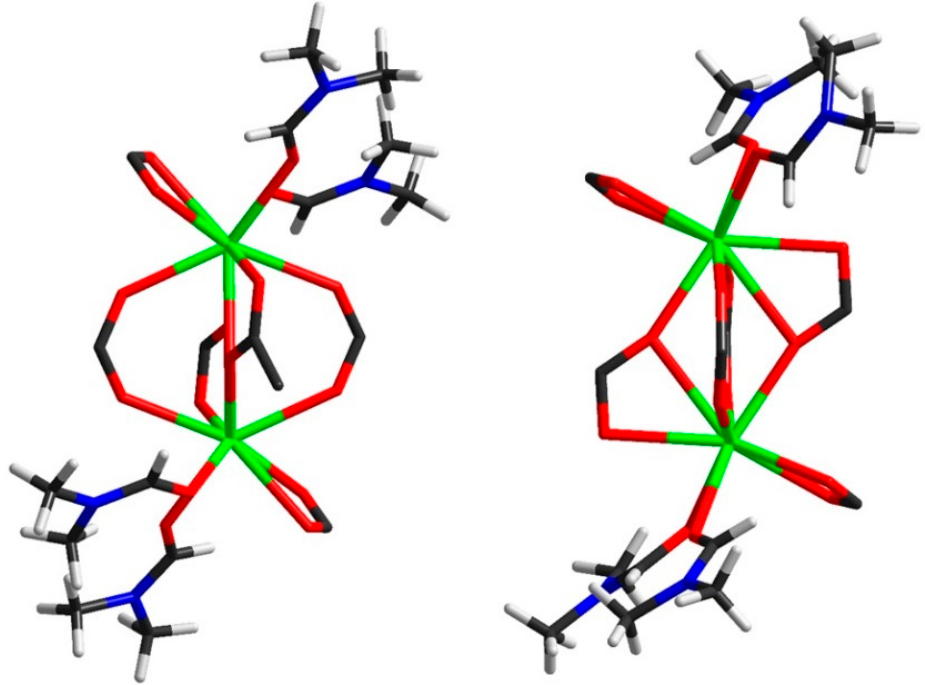
Figure 4. Geometry of the [La 2 (2,5-I-bdc) 6 (DMF) 4 ] units in 1 (left) and 2 (right). The reorientation of dicarboxylic ligands (Figure 5) leads to a change in the topol- ogy of the coordination polymer from 2D to 3D. In the crystal structure of 2 , each